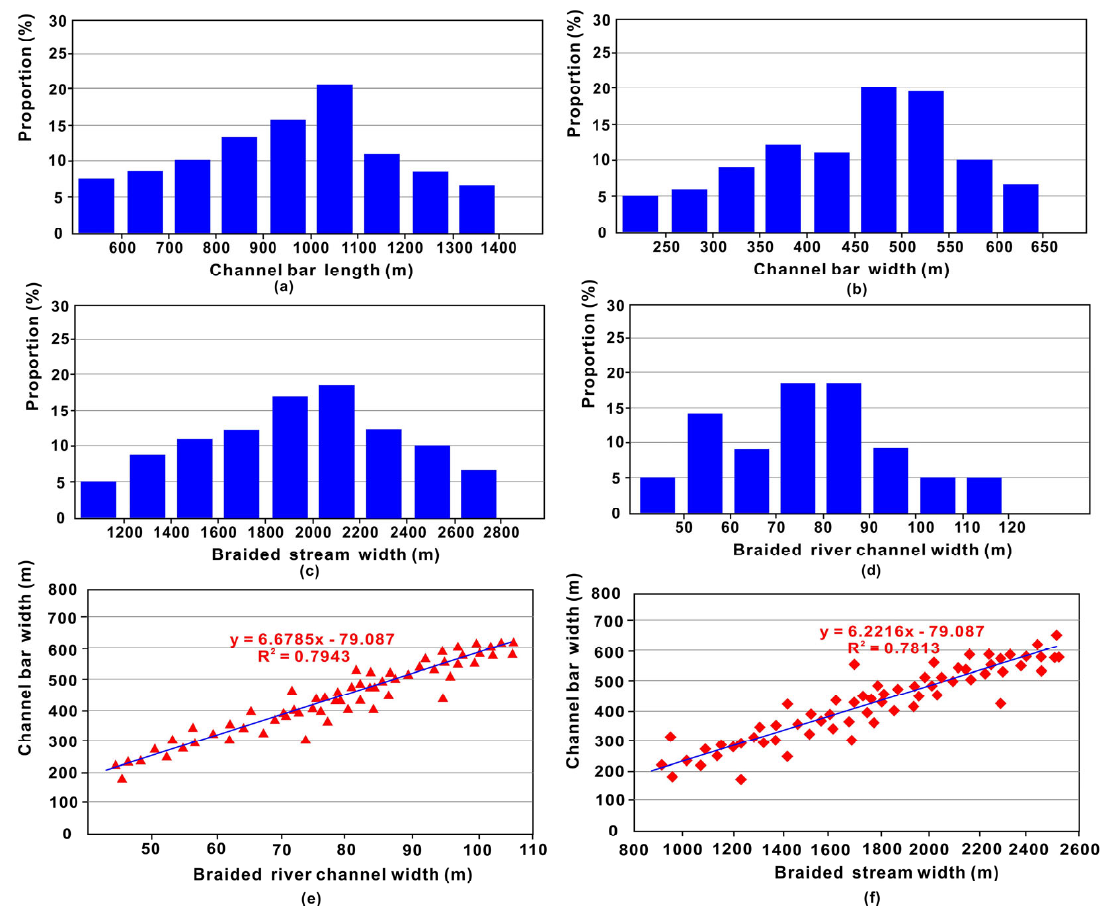
Figure 5. ( a ) Frequency distribution histogram of channel bar length. ( b ) Frequency distribution histogram of channel bar width. ( c ) Frequency distribution histogram of braided stream width. ( d ) Frequency distribution histogram of braided river channel width. ( e ) Relationship between the width of channel bar and braided river channel (the red triangle is the data point). ( f ) Relationship between the width of channel bar and braided stream (the red rhombus are data